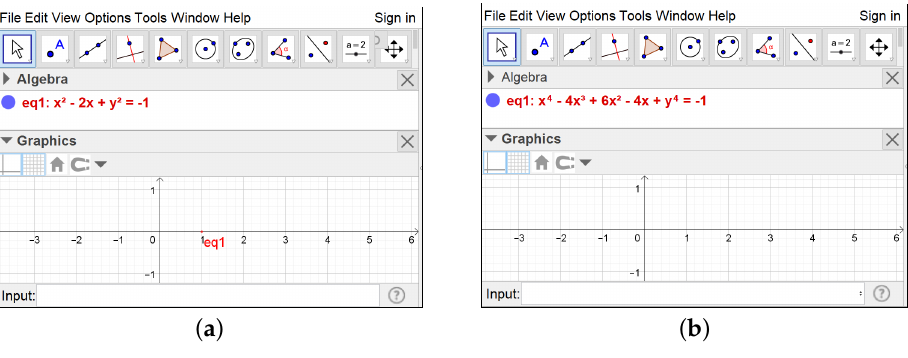
Figure 6. GeoGebra output for the implicit curves ( x − 1 ) 2 + y 2 = 0 (success, subfigure ( a )) and ( x − 1 ) 4 + y 4 = 0 (failure, subfigure ( b )).